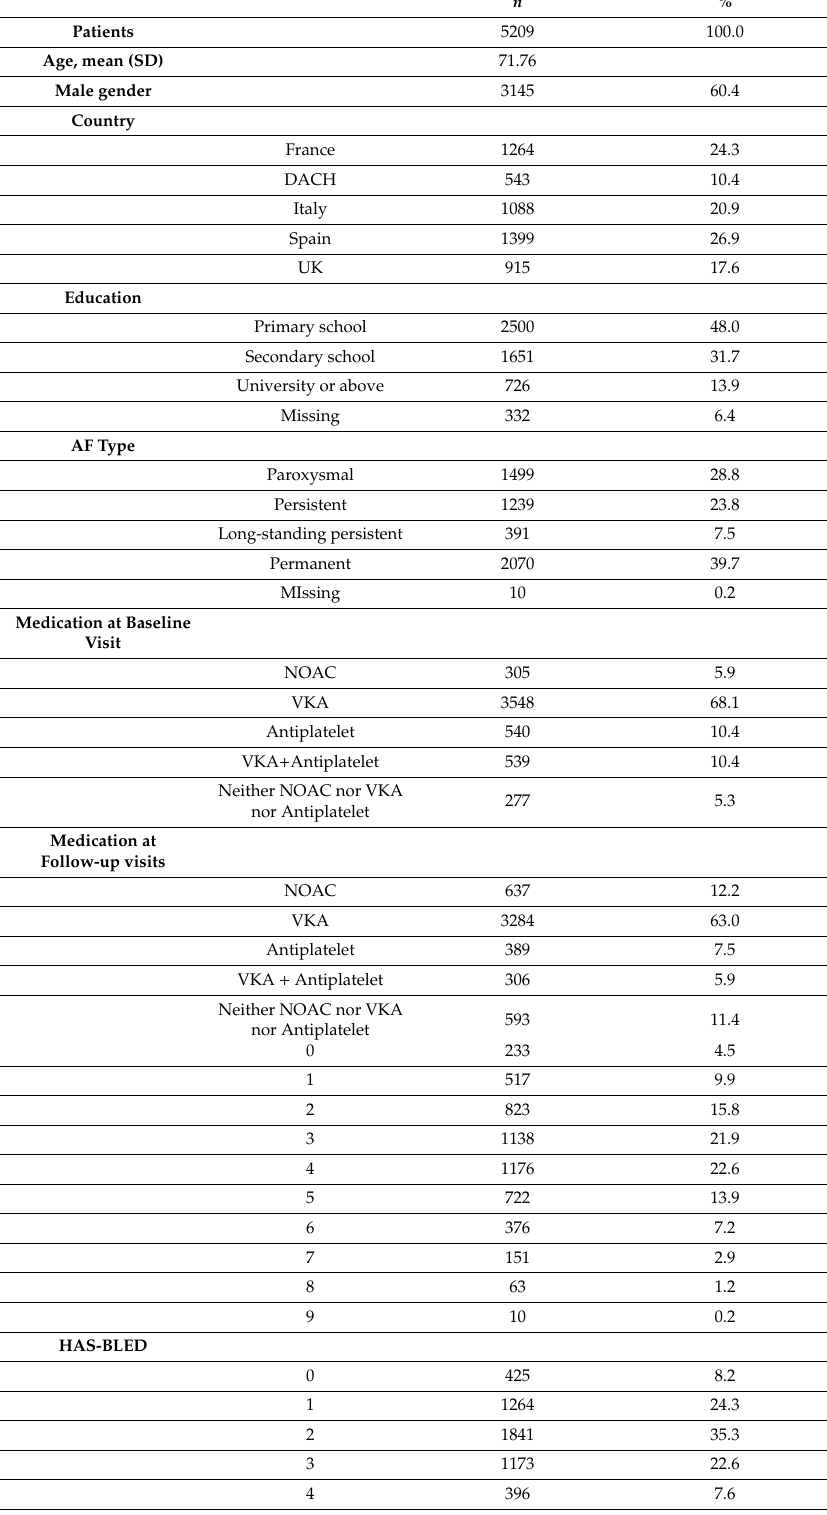
Table 1. Patients’ characteristics at